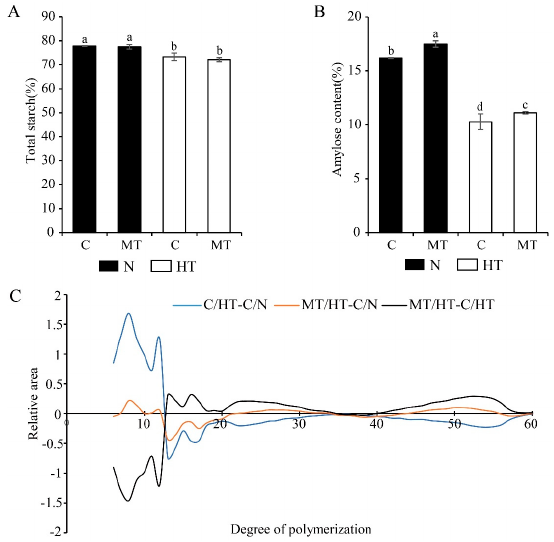
Figure 4. Effects of melatonin treatment on the starch synthesis of NPB grown at different tempera- tures. ( A ) Total starch content of NPB grains with different treatments. ( B ) Amylose content of NPB grains with different treatments. ( C ) HPAEC analysis of NPB grains with different treatments. The data presented in the figure are repeated through three independent experiments, values with dif- ferent letters (a, b, c and d) in the same column are significantly different at p < 0.05, calculated by one-way ANOVA. “N” and “HT” indicate normal and high temperature conditions. “C” and “MT” indicate H 2 O and melatonin treatment, respectively.